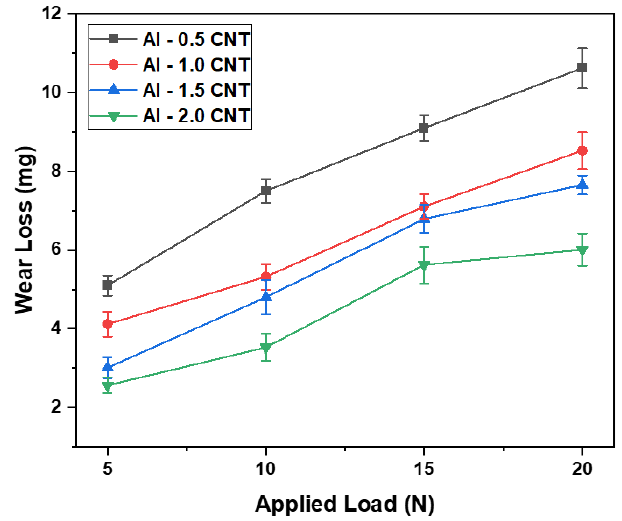
Figure 9. Effect of applied load on wear loss for composite samples prepared with different CNT content in dry sliding condition.